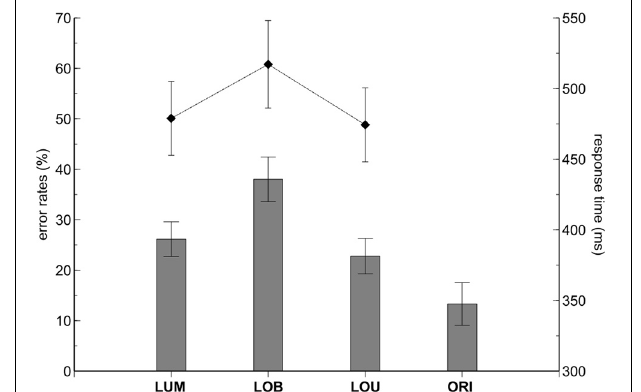
FIGURE 2 | Behavioral results. The contralateral distractor condition (LOB) revealed higher error rates (bars) and response times (diamond shapes) compared to the remaining stimulus conditions. While both error rates and RTs did not differ between the LUM and LOU conditions, lower error rates were revealed in the No-Go ORI condition compared to all conditions containing a relevant luminance change (LUM, LOB, LOU). The error bars depict the standard error of the